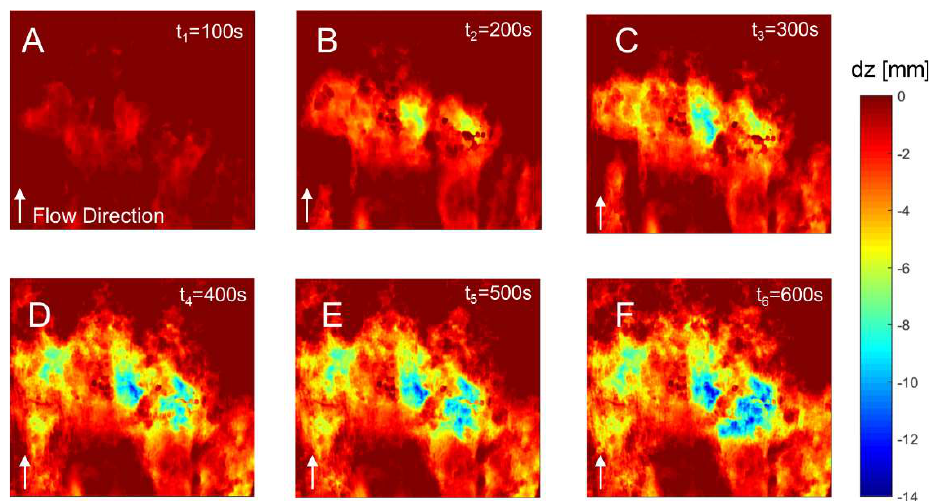
Figure 8. Temporal erosion progress of the erosion experiment with Q 2 = 11.3 L/s ( x - y -plane) at six selected time-steps (Δt = 100 s).